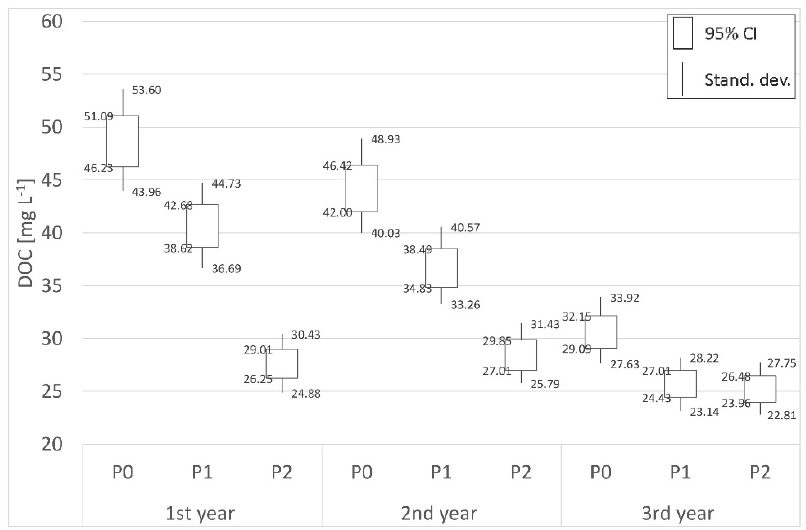
Figure 3. The concentrations of TDC in groundwater under shelterbelt. Table 4. Mean concentrations of TDC and DOC in groundwater under peatland and shelterbelt soils.